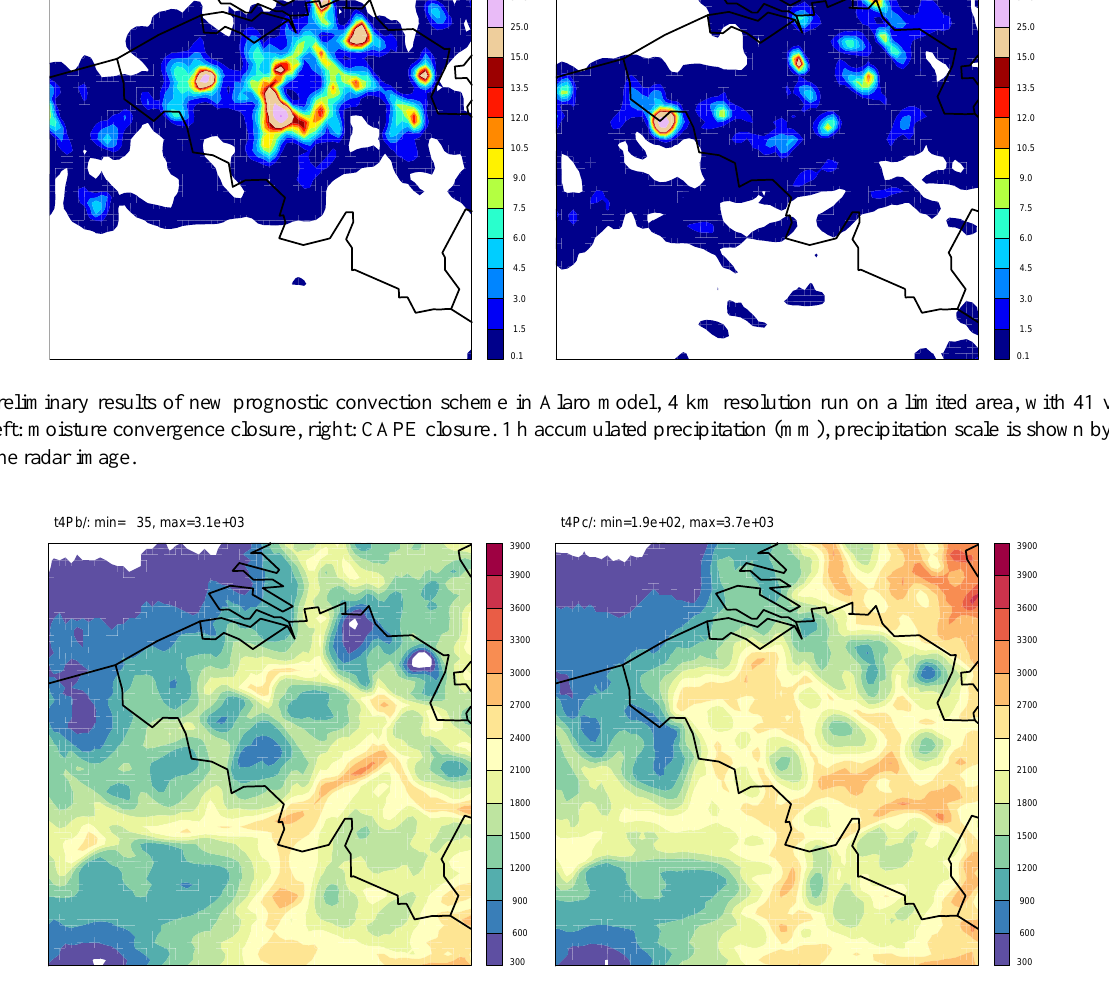
Fig. 3. The same as Fig. 2, but for a horizontal distribution of CAPE.